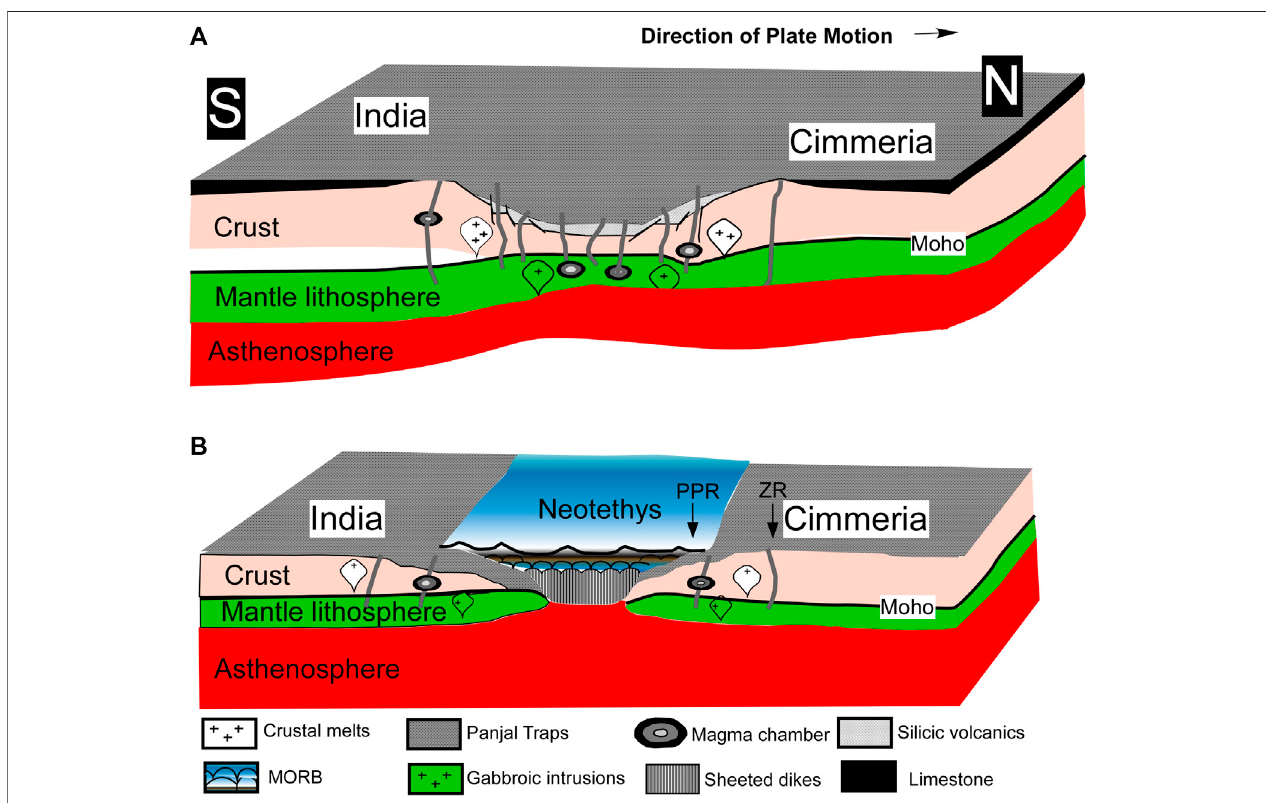
FIGURE 7 | The formation of Panjal Traps is shown in two stages. (A) The rifting of India and Cimmeria resulted in the formation of normal faults, which at the later stage of rifting facilitated the eruption of Panjal Traps. (B) The opening of the Neotethys ocean occurred during the fi nal stages of rifting, and later this ocean was closed during the subduction and subsequent collision of India with Tibet occurred sometime in Eocene (modi fi ed after Shellnutt, 2018).